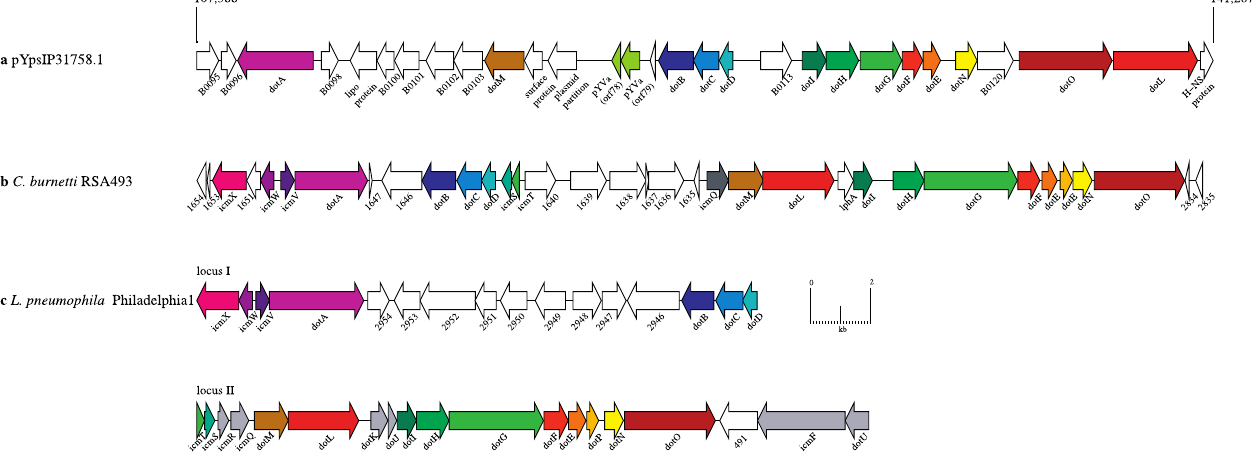
Figure 7. Genomic Architecture of the pYpsIP31758.1-Borne Type IVB Locus and Comparative Analyses to That of C. burnetti RSA493 and L. pneumophila Philadelphia 1 The plasmid pYpsIP31758.1 type IVB locus (A) encodes 28 genes and is compared to that of C. burnetti RSA493 (B) and L. pneumophila Philadelphia 1 (C). The scale in bp indicates the genomic location of the type IVB locus from YpsIP31758_B0095 to YpsIP31758_B0122. Corresponding CDSs involved in type IVB pilus assembly are colored accordingly; species-specific CDSs often found interspersed are colored white. icm/dot genes that are unique to C. burnetti and L. pneumophila are colored in dark gray and light gray,